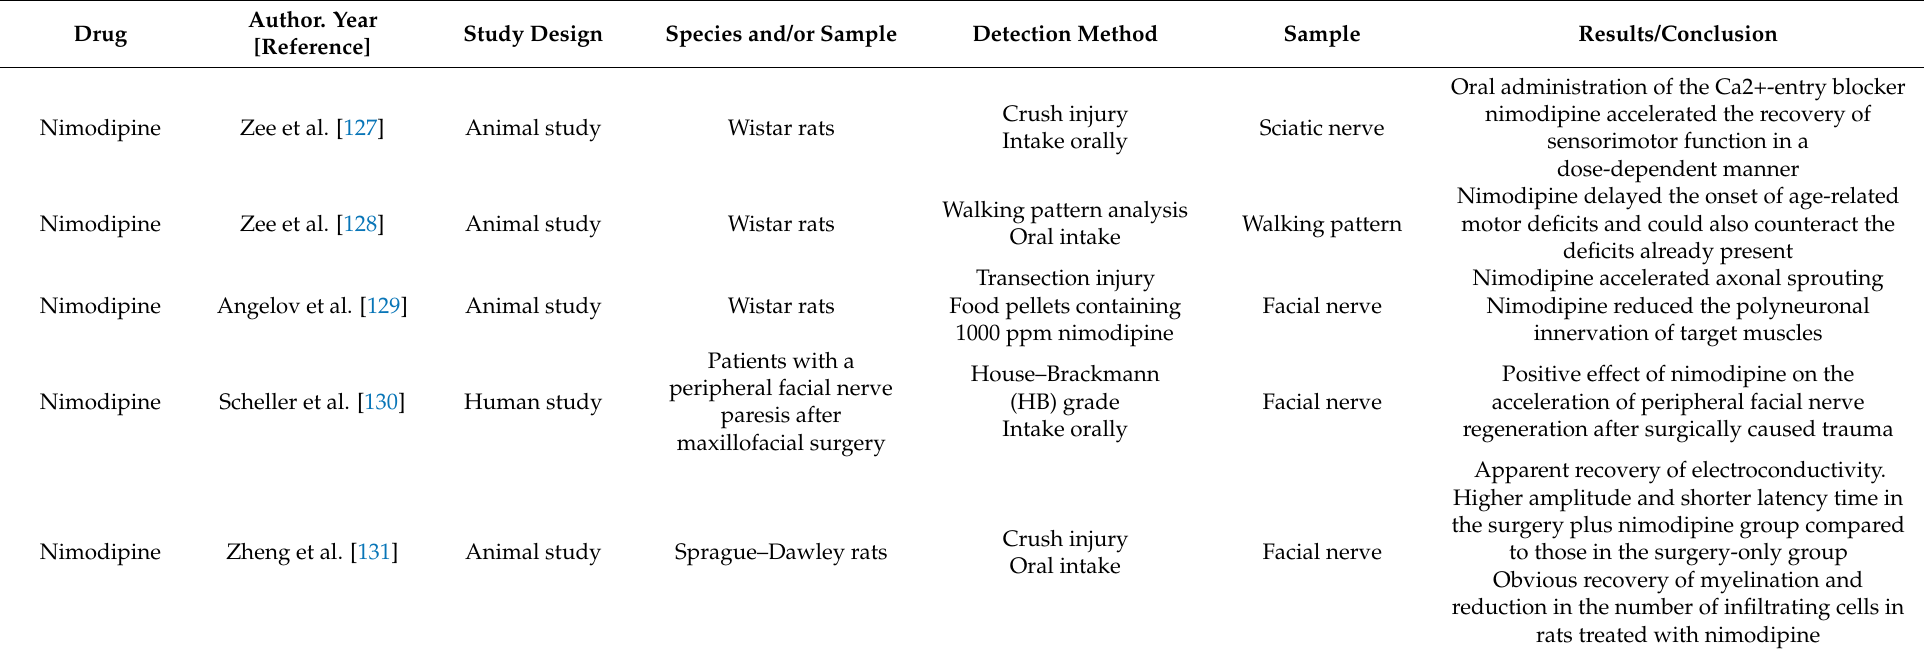
Table 10. Summary of studies that used nimodipine to treat peripheral nerve